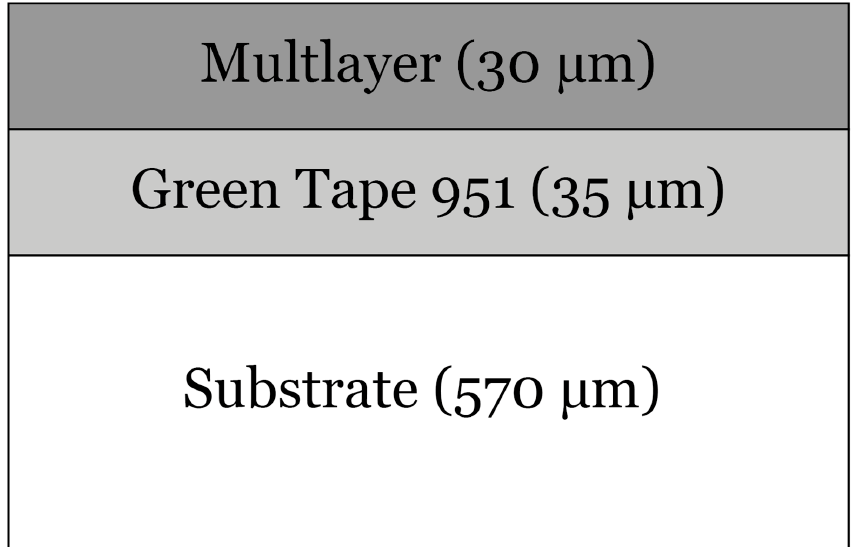
Figure 3. Schematic of reactive multilayer on LTCC substrate with DP 591 isolation layer.